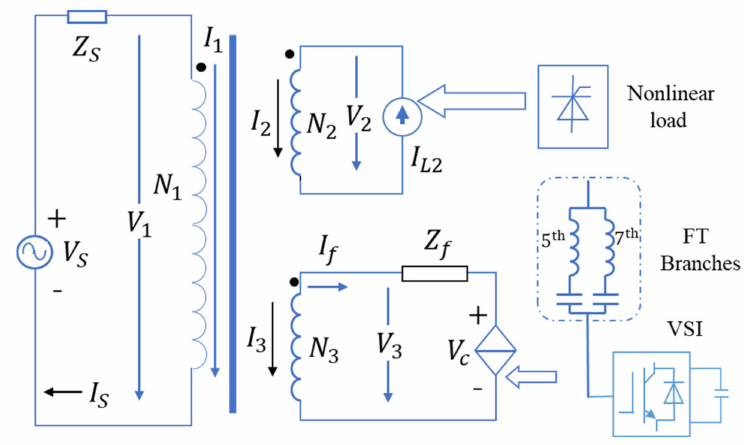
Figure 3. Schematic of the single-phase topology of the proposed HIAF